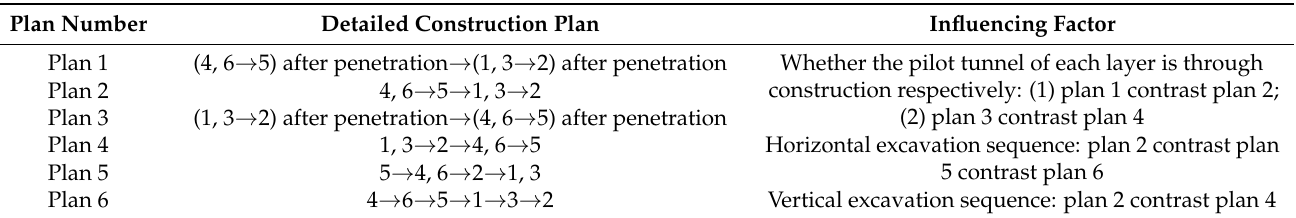
Table 4. Specific scheme of working conditions.